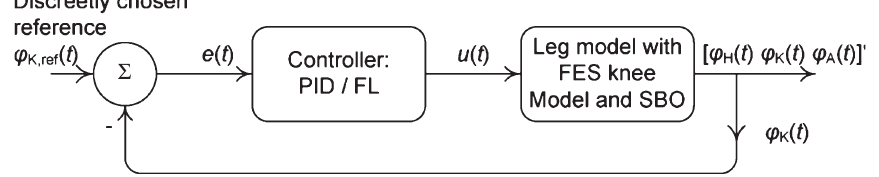
Fig. 5. SBO control scheme-I: closed-loop control of SBO with discreetly chosen trajectory. ϕ H ( t ), ϕ K ( t ) and ϕ A ( t ) are hip, knee and ankle joint trajectories